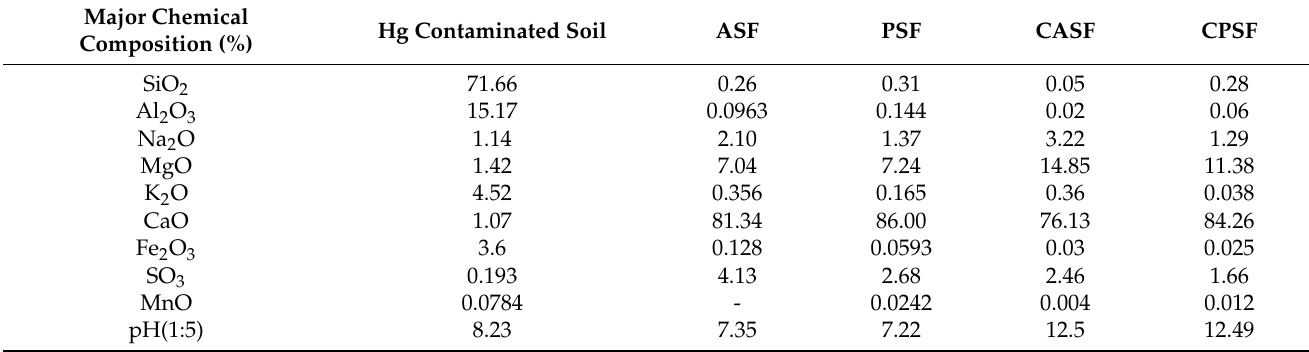
Table 2. Major chemical composition of Hg contaminated soil, ASF, PSF, CASF and